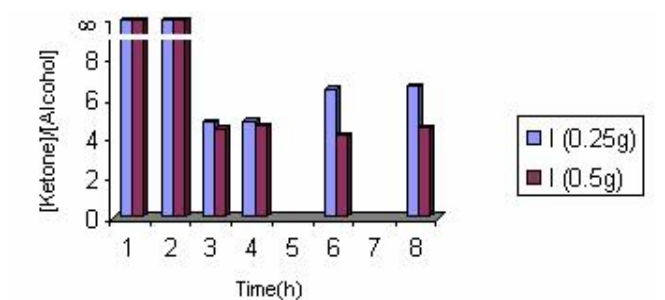
Figure 12. Variation of the [acetophenone]/[1-phenylethanol] ratio vs. time in experiments 10 and